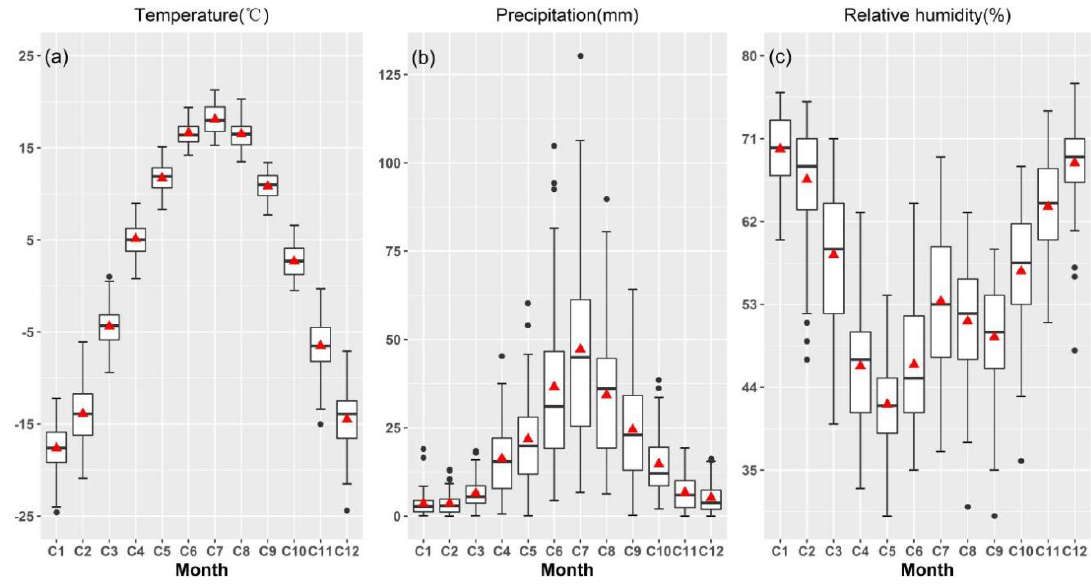
Figure 2. Monthly mean temperature ( a ), total precipitation ( b ), and relative humidity ( c ) in Barkol Meteorological Station in eastern Tianshan Mountains from 1958 to 2012. Black dots: outliers; red triangles: average values; lower dash: minimum (excluding outliers); bottom of box: 25% of data; middle line of box: data 50% (Median); top of box: 75% of data; upper dash: maximum (excluding outliers).